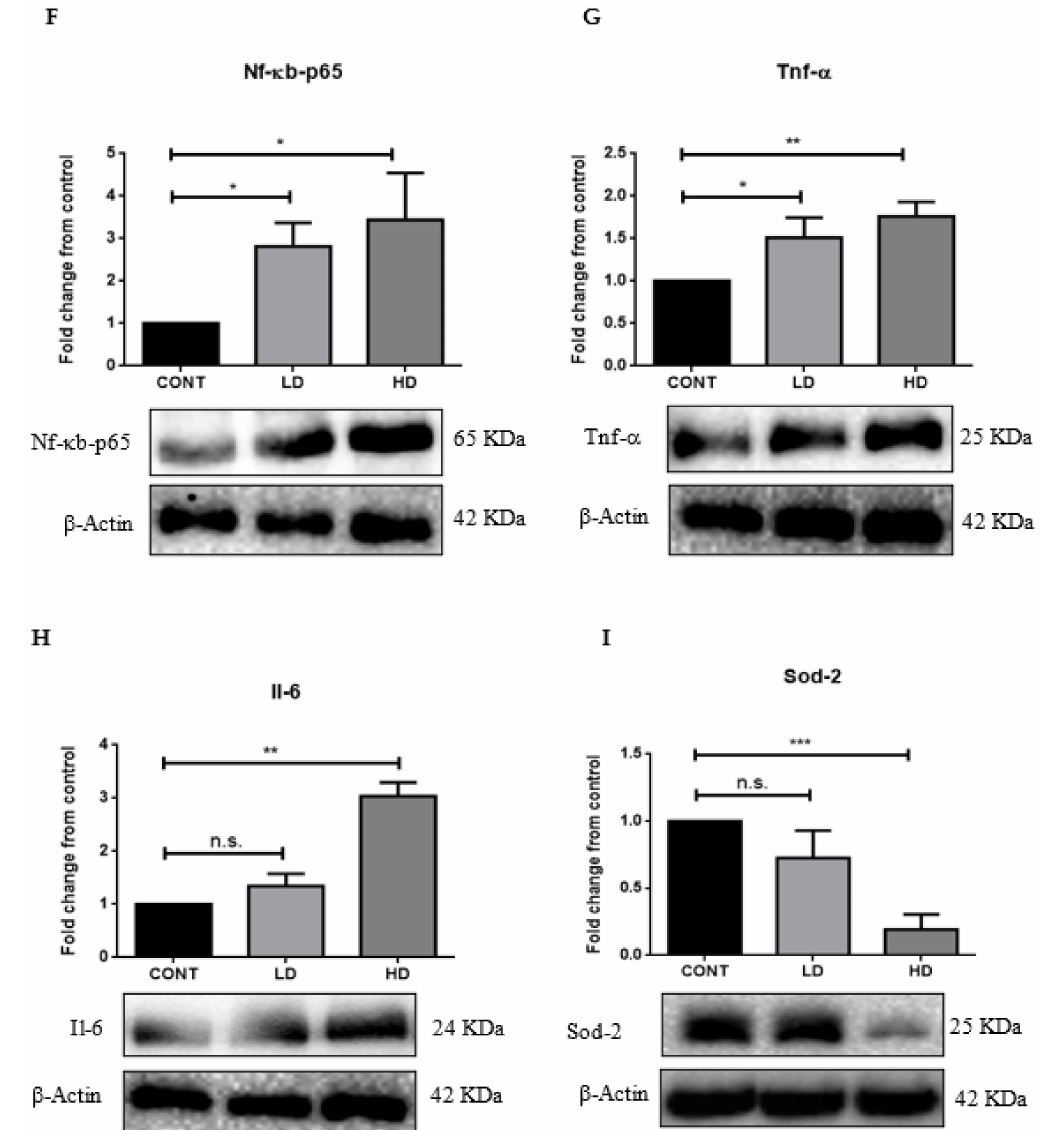
Figure 5. VTX-induced oxidative stress and inflammation in the heart. ( A – E ) The mRNA levels of Ifn- γ , Tgf- β , Nf- κ b-p-65 , Tnf- α , and Il-6 were measured using RT-PCR. Data were normalized to β -actin as a housekeeping gene and one-way analysis of variance (ANOVA), followed by Tukey–Kramer multiple-comparisons tests. ( F – I ) Representative Western blot analysis of protein levels of Nf- κ b-p-65, Tnf- α , Il-6, and Sod-2. Data are presented as mean ± SD ( n = 5). * p < 0.05, ** p < 0.01, *** p < 0.001; n.s., no significant changes were observed ( p > 0.05). Cont, control; LD, low-dose venetoclax (50 mg/kg); HD, high-dose venetoclax (100 mg/kg); Ifn- γ , interferon gamma; Tgf- β , transforming growth factor beta; Nf- κ b-p-65, nuclear factor kappa-B; Tnf- α , tumor necrosis factor alpha; Il-6, interleukin-6;